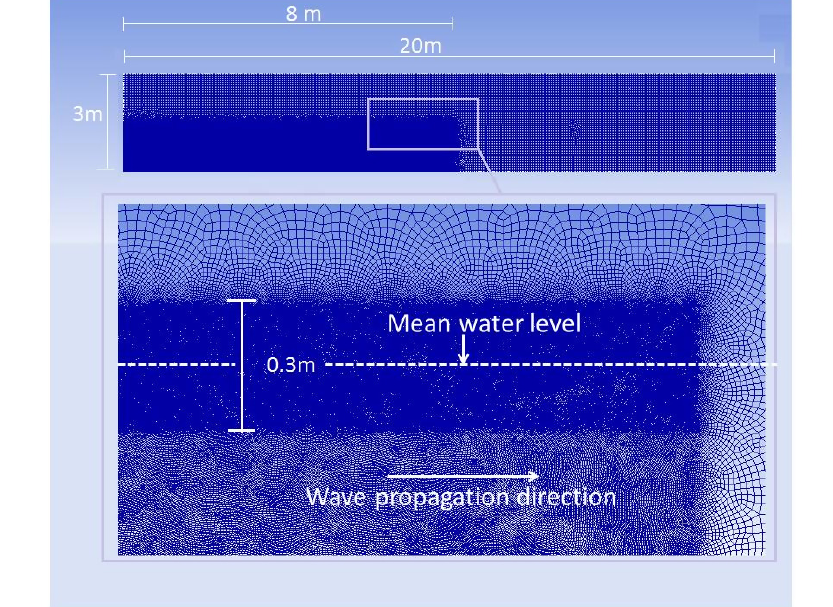
Figure 1. Details of the problem domain (top panel) and mesh refinement near the surface (bottom panel). The darker blue represents areas with more refined mesh. The mesh downstream of the domain is not well resolved in order to dissipate the wave energy before reaching the end wall at x 1 = 20 m and to ensure the wall is